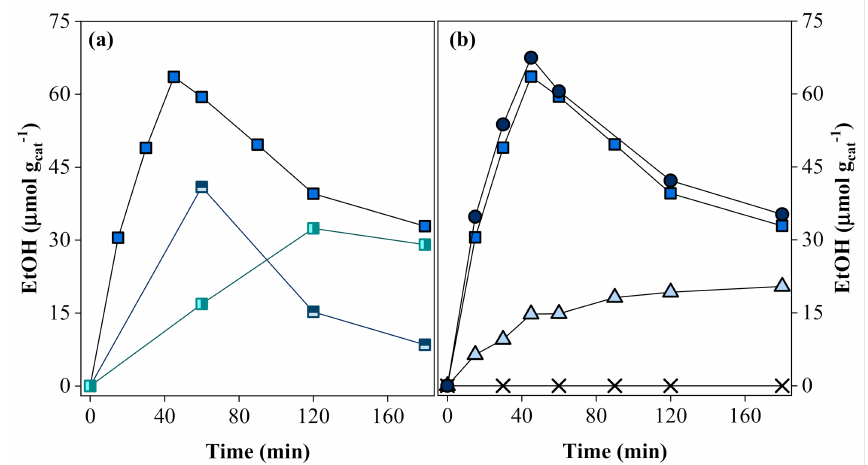
Figure 6. Evolution of the ethanol production from CO 2 and C 2 H 6 as a function of the photoreaction time, using different SrTiO 3 :RuO 2 :NiO photocatalyst compositions: ( a ) Ru loadings of 0.2 wt.% (